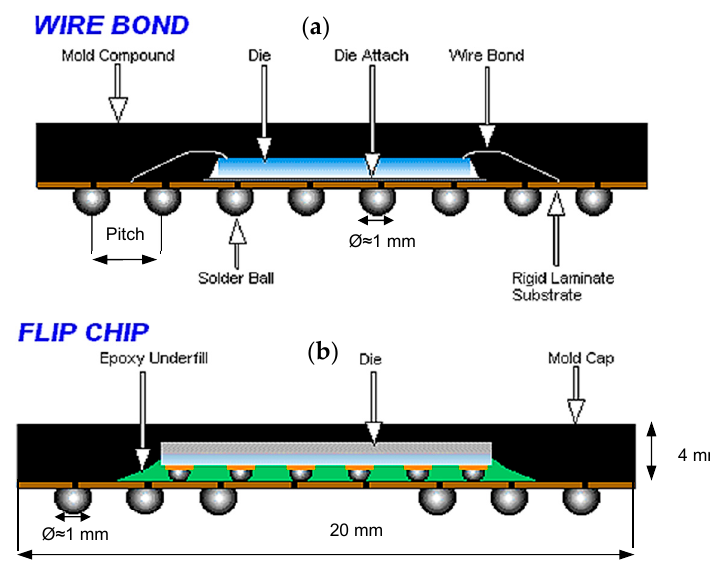
Figure 1. Comparison of wire bond BGA and FCBGA packages: ( a ) Wire bond BGA: the die faces up and attached to the package via wires, ( b ) FCBGA: the die faces down and attached via solder bumps (courtesy of Amkor Technology, Inc., Tempe, AZ, USA).